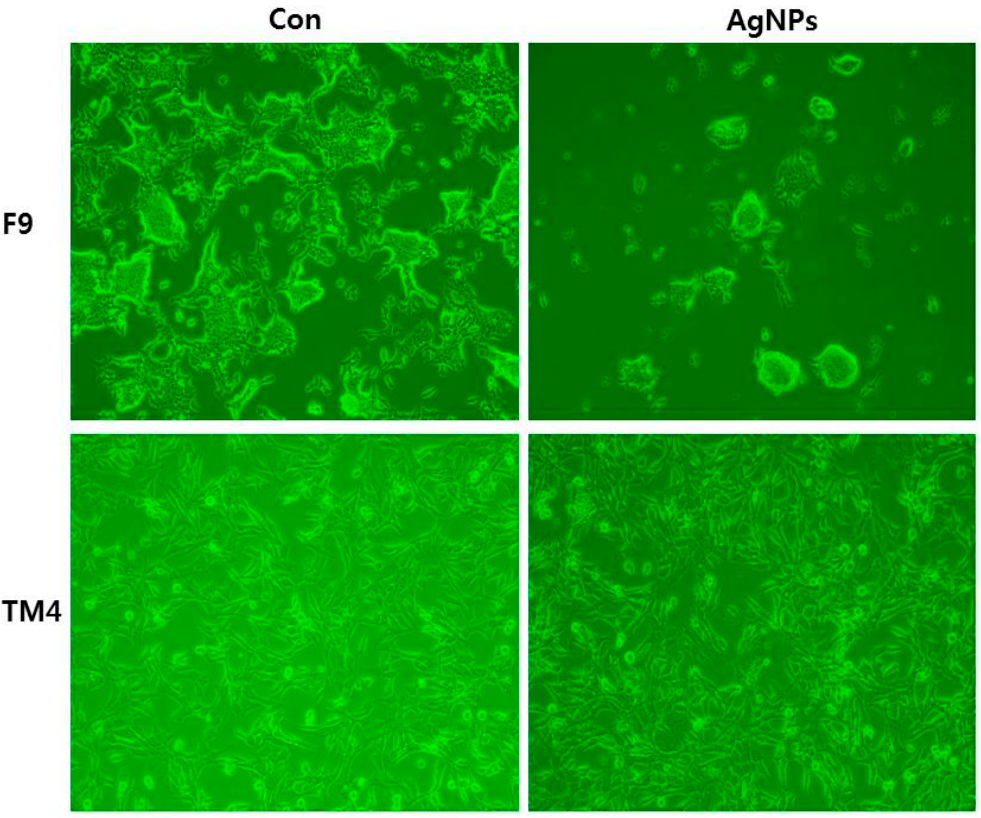
Figure 6. Effect of silver nanoparticles on cell morphology of teratocarcinoma stem cell line F9 and Sertoli (TM4) cells treated with 40 nm AgNPs. The images were taken from cells with an average size of 40 nm treated for 24 h.